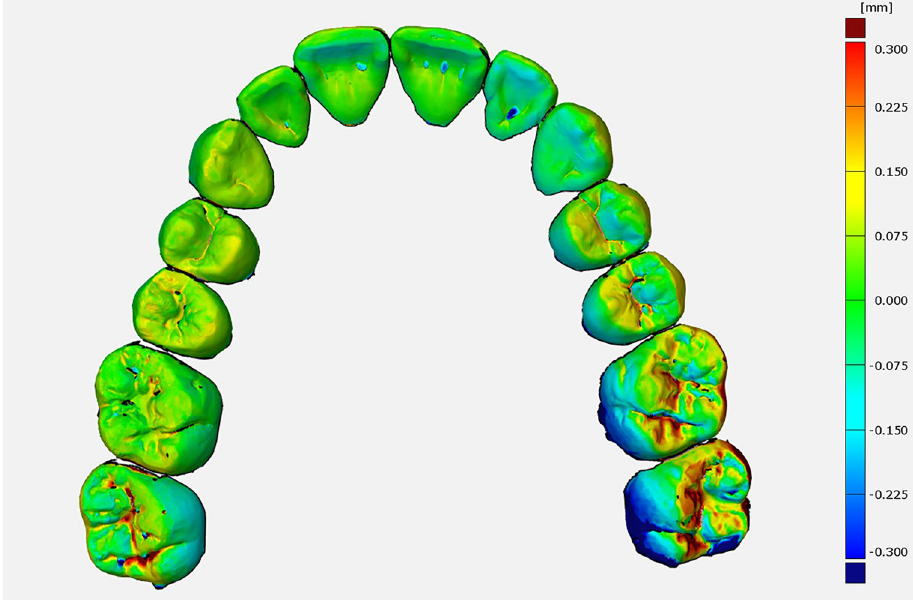
Figure 4. Color coded, 3D superimposition showing deviations of the Trios 3 scan to the reference cast between the anterior and posterior segments based on the example of one